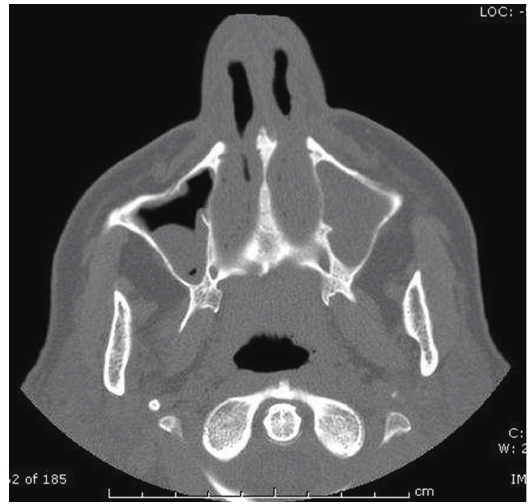
Figure 1: CT scan—mucous obliteration of the maxillary sinus (complete in the left, partial in the right); thickened and swollen nose soft tissues without osteostructural alterations.